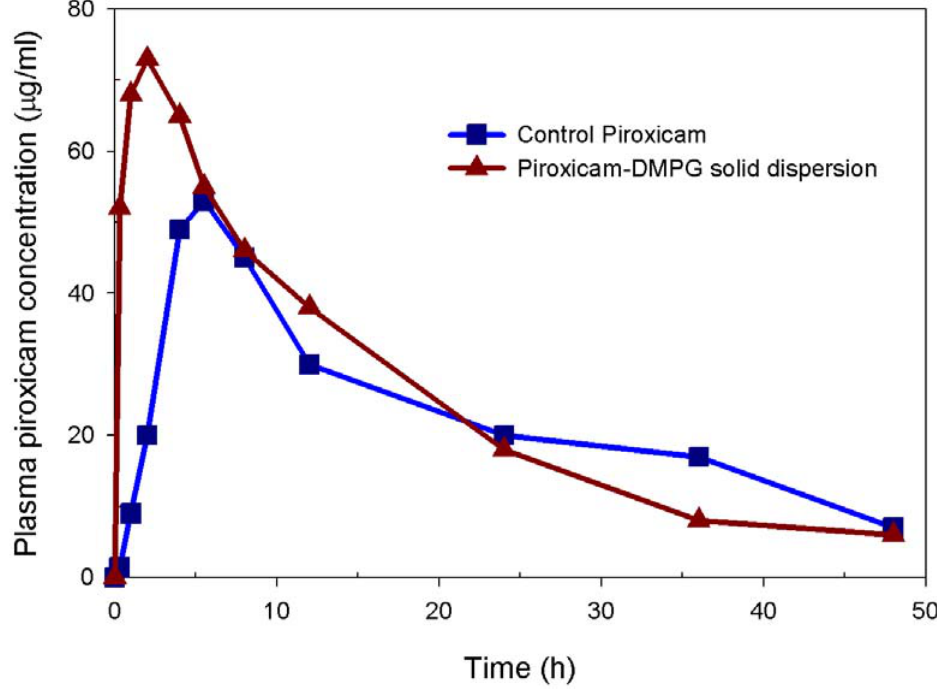
Figure 4. Representative plasma concentration-time profiles for two piroxicam formulations. The DMPG-based solid dispersion formulations of piroxicam were administered orally to rats and compared to the same dose of control piroxicam (20